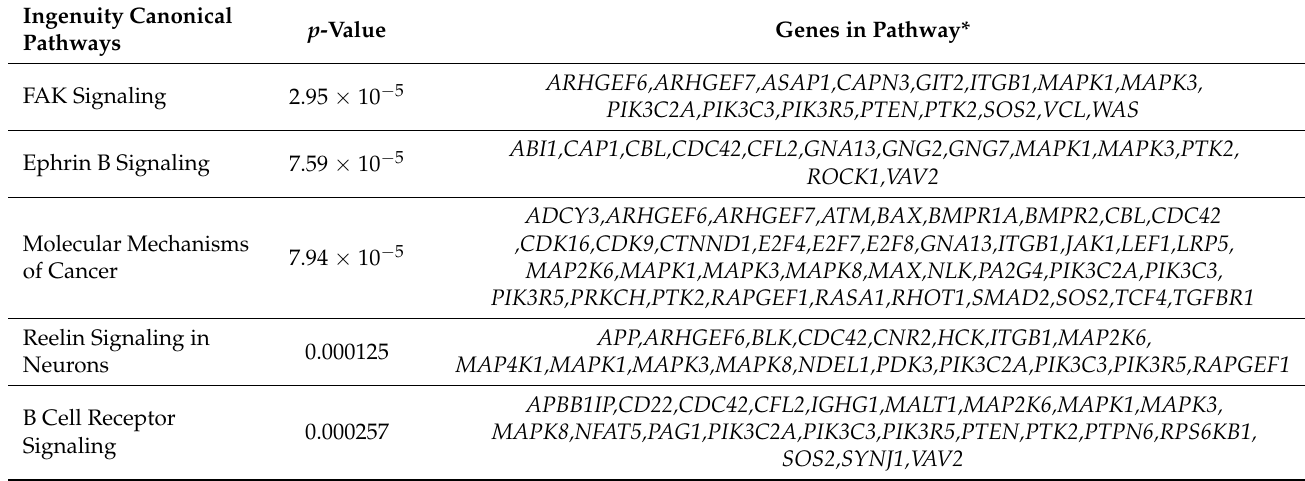
Table 6. Top five canonical pathways identified by IPA in lymphoblastoid cells and the differentially-regulated genes associated with these